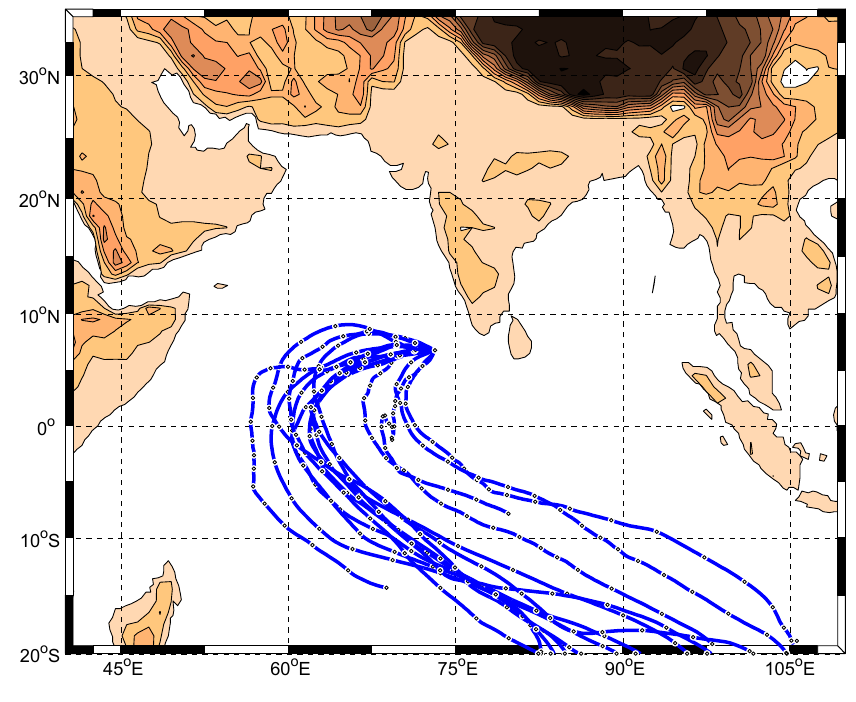
Fig. 4. 10 days backward trajectory cluster with the arriving hight of 50 meter for the data selection “South Indian